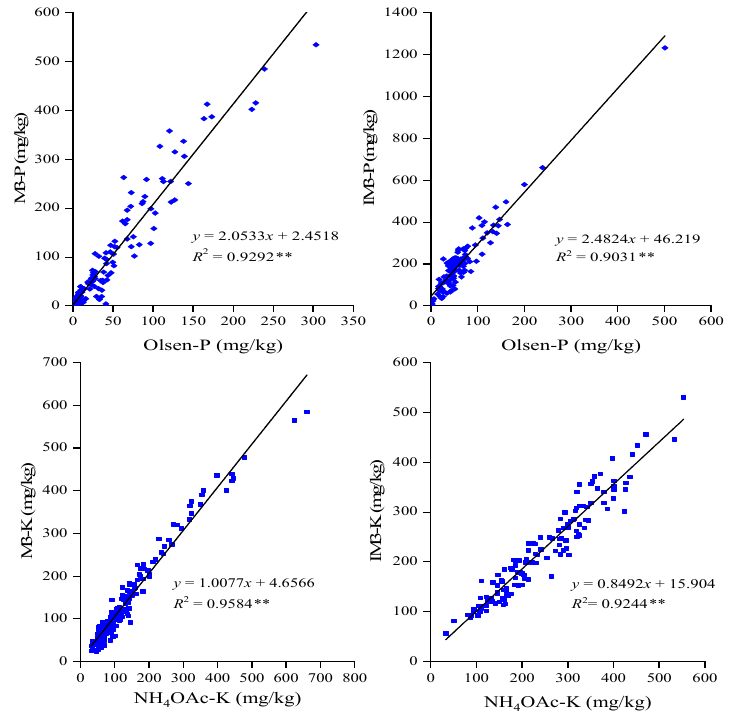
Figure 2. The correlations of the contents of soil available P and available K determined by three test methods (** p < 0.01).